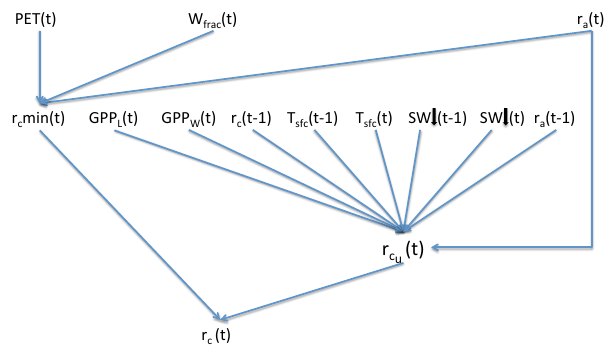
Figure 2. Canopy resistance dependencies and updating in